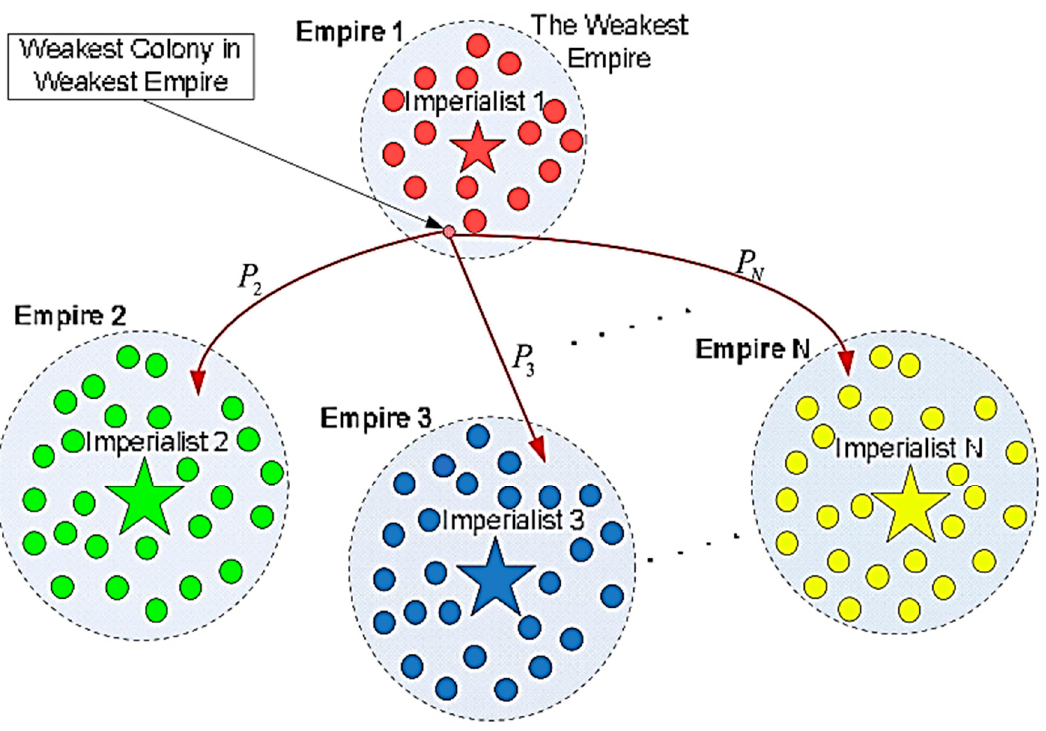
Figure 3. Taking possession of the weakest colony during the imperialistic competition (after Reference [42]).